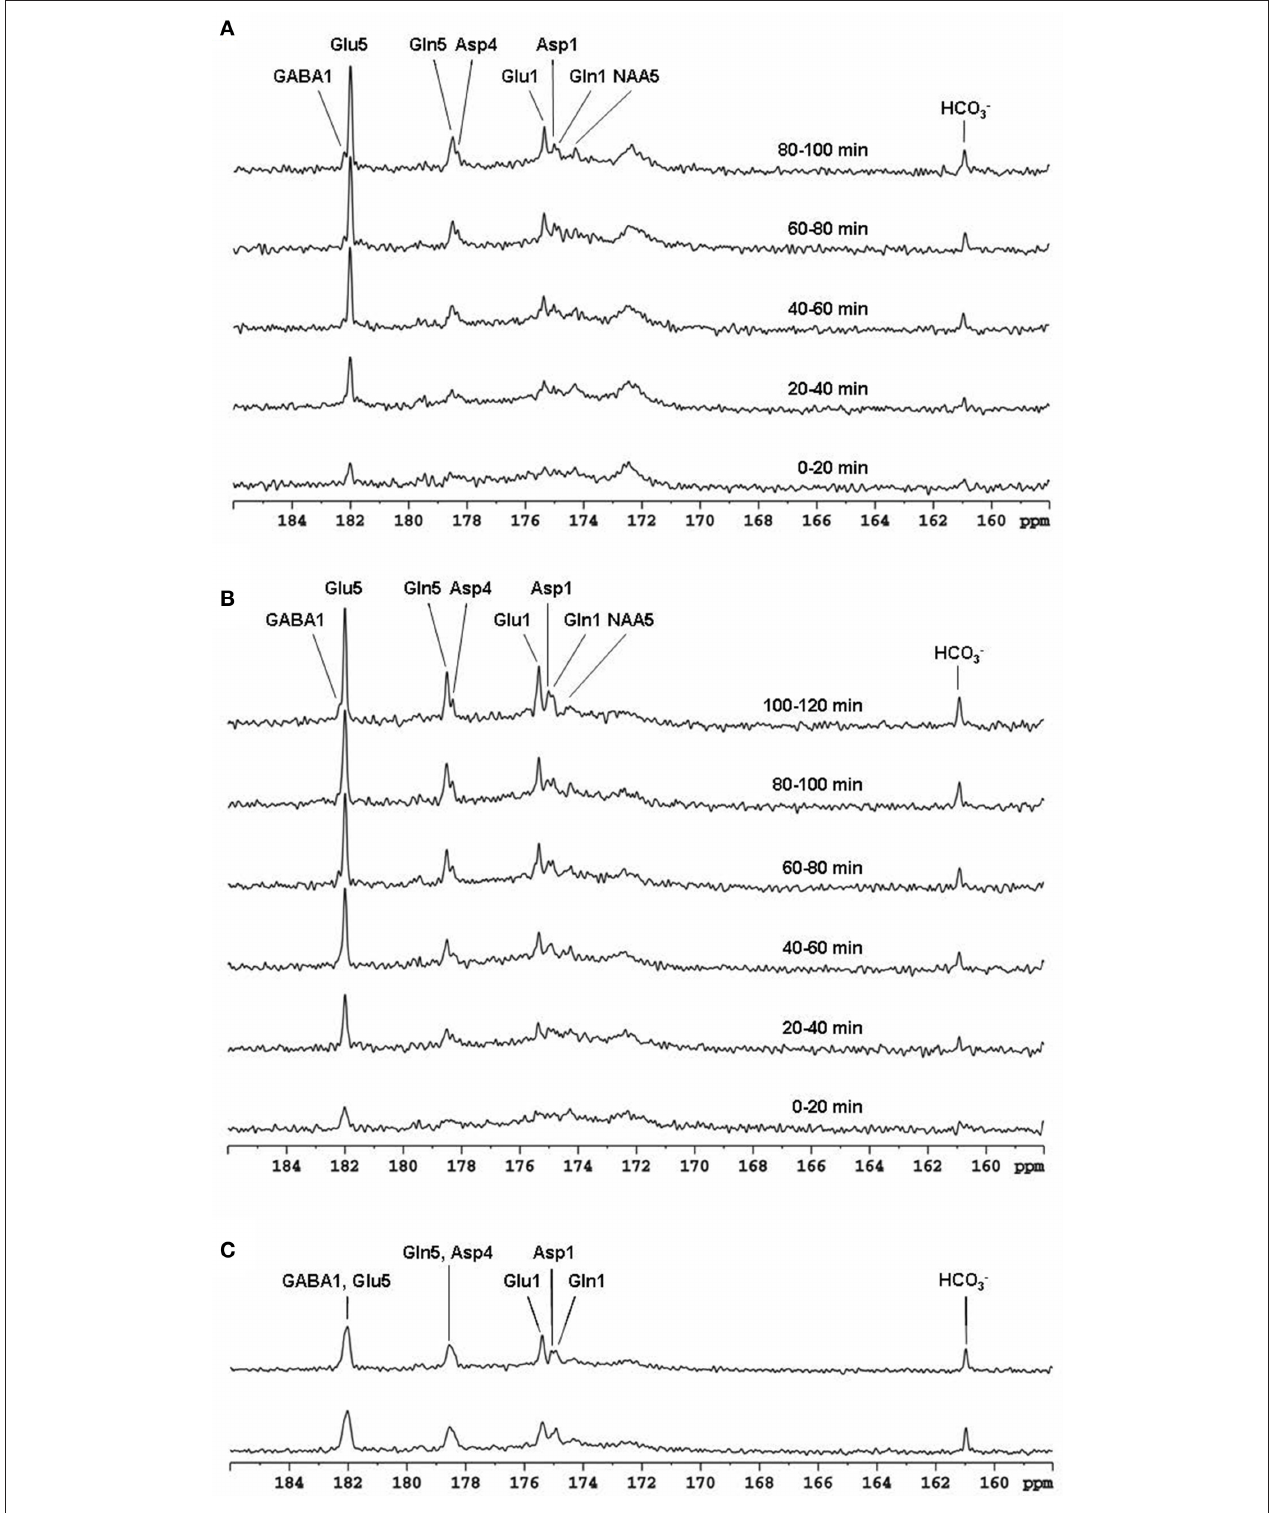
FIGURE 2 | Time-course spectra of the dynamic turnover of Glu, Gln, Asp, GABA, and bicarbonate from intravenously infused [2- 13 C] Glc detected in vivo in the monkey brain at 4.7 Tesla using pseudo noise decoupling pulse (A) and vectorial noise decoupling pulse (B) . Spectrum acquired using WALTZ-4 decoupling (upper trace) is compared with undecoupled spectrum in (C) . Only a negligible decoupling effect is shown using WALTZ-4 at the low power level. Acquisition parameters for all spectra were: sweep width 10 kHz, acquisition time 204 ms, TR 2.3s. Adapted from Li et al. [28].